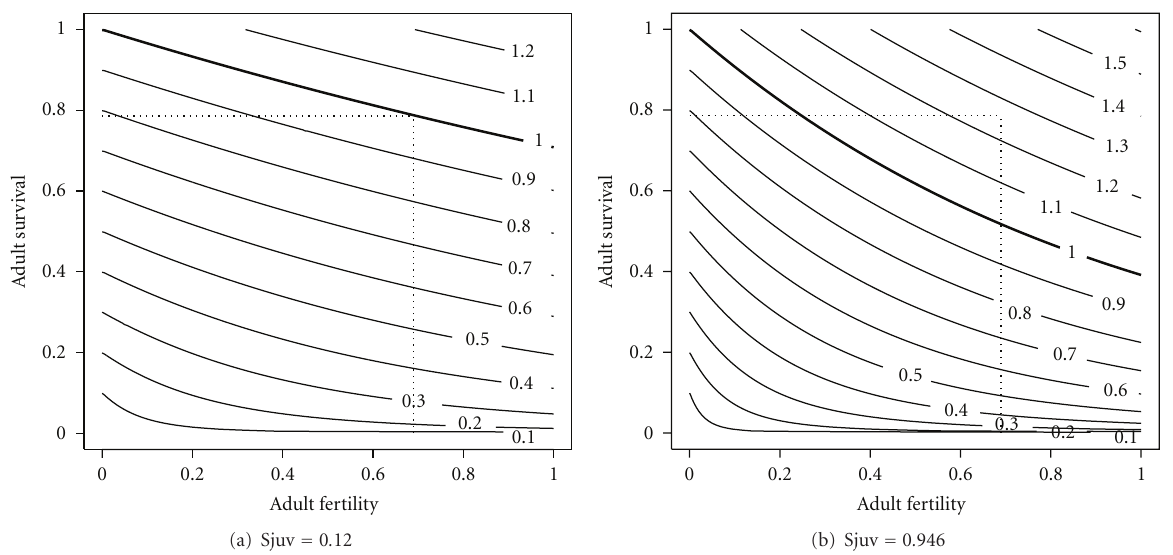
Figure 4: Sensitivity of λ to varying adult demographic rates (range [0, 1]), when juvenile survival ( s j ) is set to (a) 0.12 and (b) 0.964 (observed juvenile mortality, see Table 2). Bold line ( λ = 1) represents the separation between set of parameters resulting in decline of the population and those resulting in growth. Dotted lines indicate the current values for s a (adult female survival) and f a (net reproduction of female native-born cubs per adult female per year).